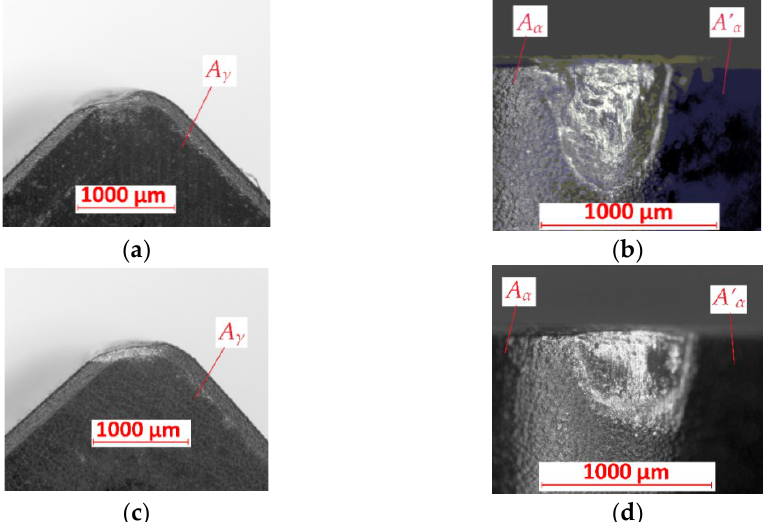
Figure 6. Results of tool ’ s wear measurements of cutting inserts after turning with f = 0.05 mm/rev of ( a , b ) FEPA 046 samples; ( c , d ) FEPA 100 samples: A γ — rake surface, A α — principal flank surface, A ’ α — auxiliary flank surface.